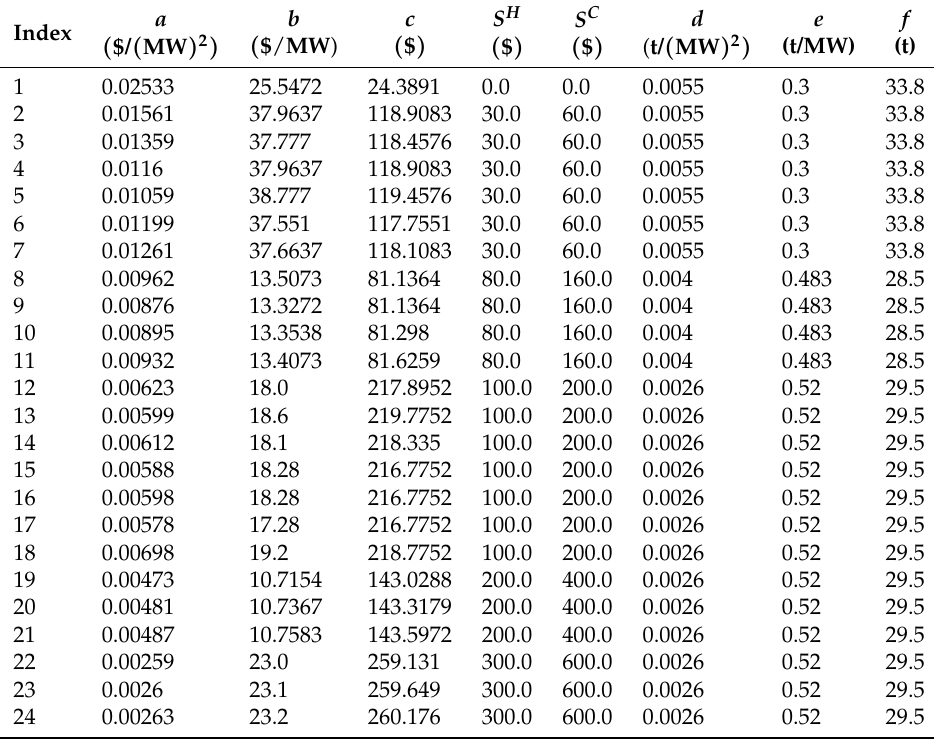
Table A4. 36 units system thermal cost and emission